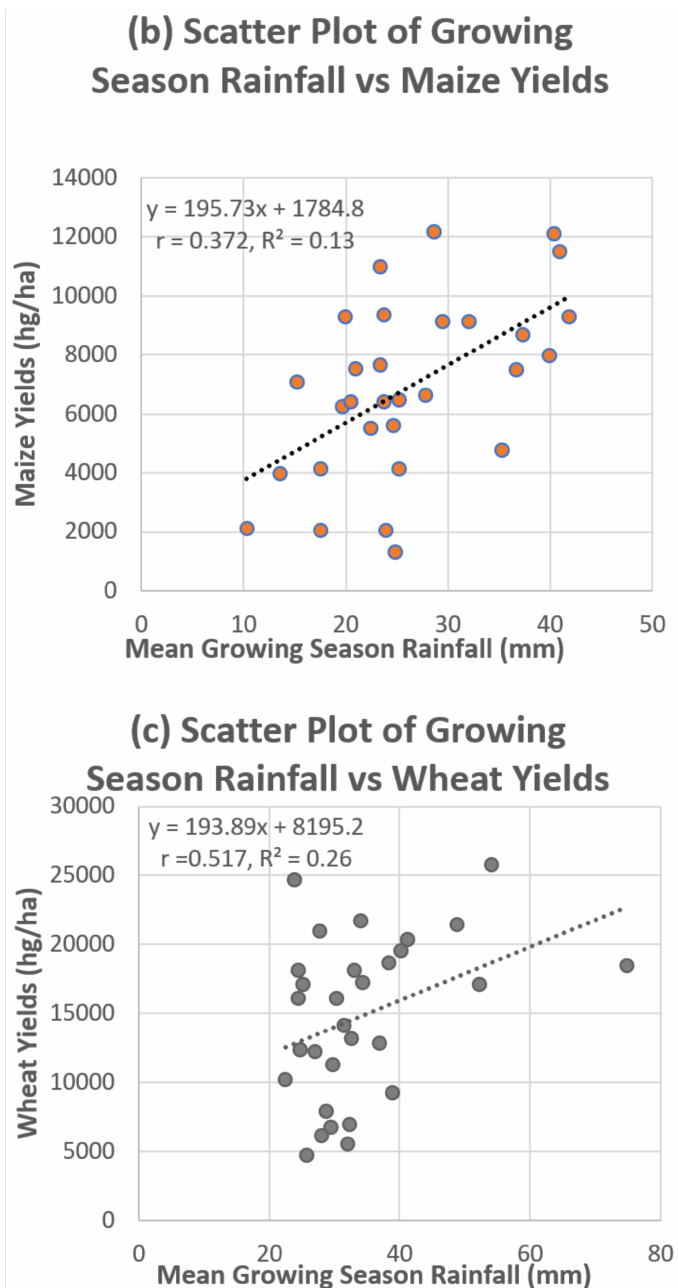
Figure 5. Scatter plots of mean growing season rainfall vs. ( a ) barley yields, ( b ) maize yields, and ( c ) wheat